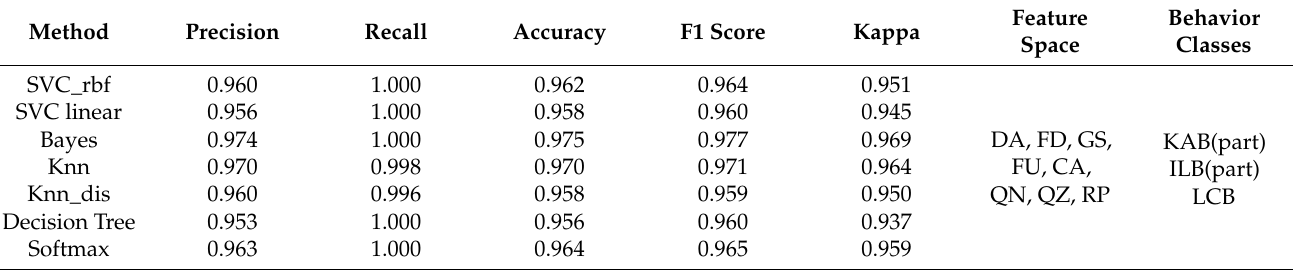
Table 5. SA-FEM’s optimal solution and optimal feature